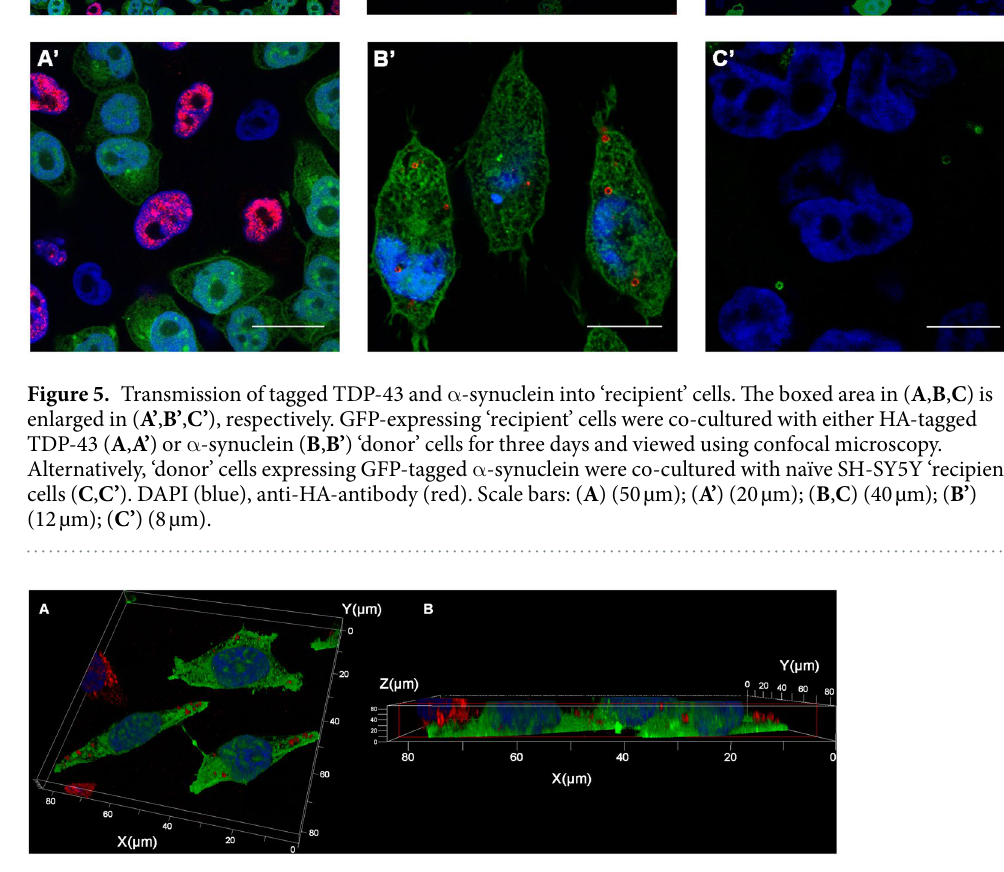
Figure 6. Three-dimensional localization of HA-tagged α -synuclein in GFP-expressing ‘recipient’ cells. GFP- expressing cells were co-cultured with ‘donor’ cells expressing HA-tagged α -synuclein for three days and 3D volume reconstruction of the Z-series ( A ) with XZ-slice projection ( B ) was performed. DAPI (blue), anti-HA- antibody (red). The interval between individual Z-stack serial images is 0.3 µ